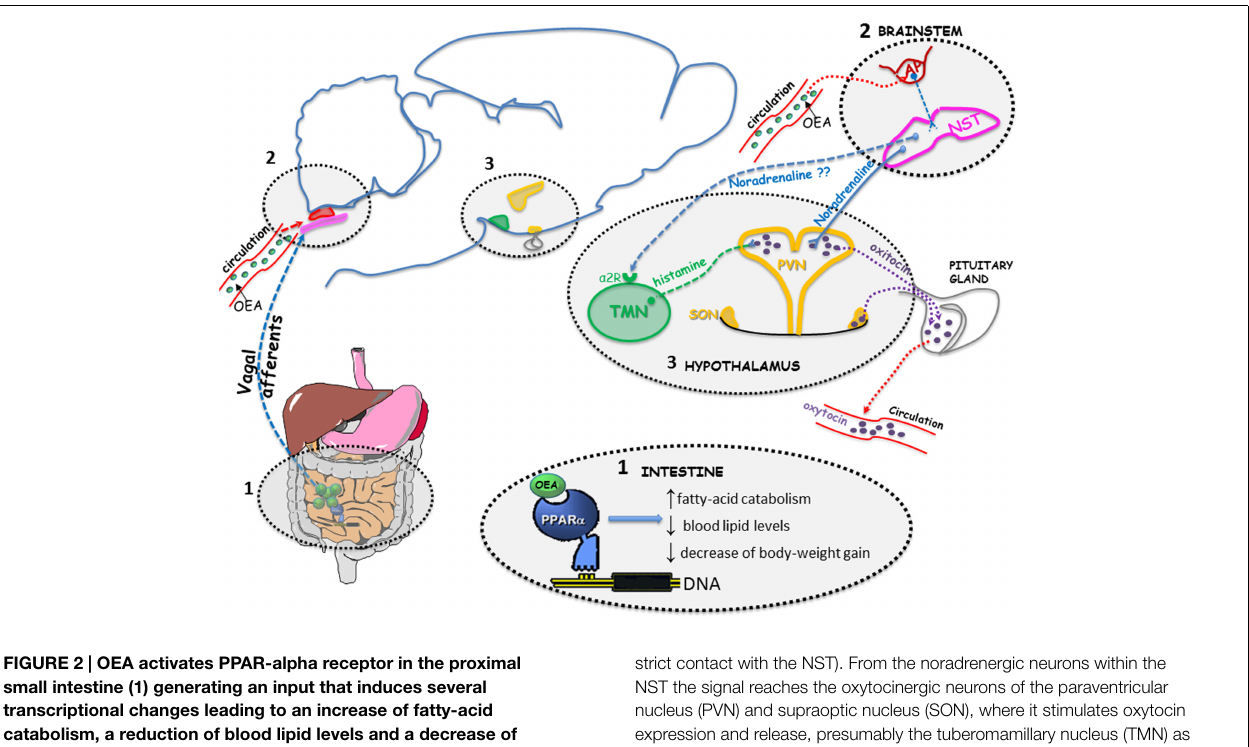
FIGURE 2 | OEA activates PPAR-alpha receptor in the proximal small intestine (1) generating an input that induces several transcriptional changes leading to an increase of fatty-acid catabolism, a reduction of blood lipid levels and a decrease of body-weight gain. The signal travels (through a mechanism that still needs to be elucidated) to the brainstem (2), in the nucleus of solitary tract (NST). Circulating OEA might reach the area postrema (AP; a circumventricular organ that lacks a functional blood brain barrier and is in